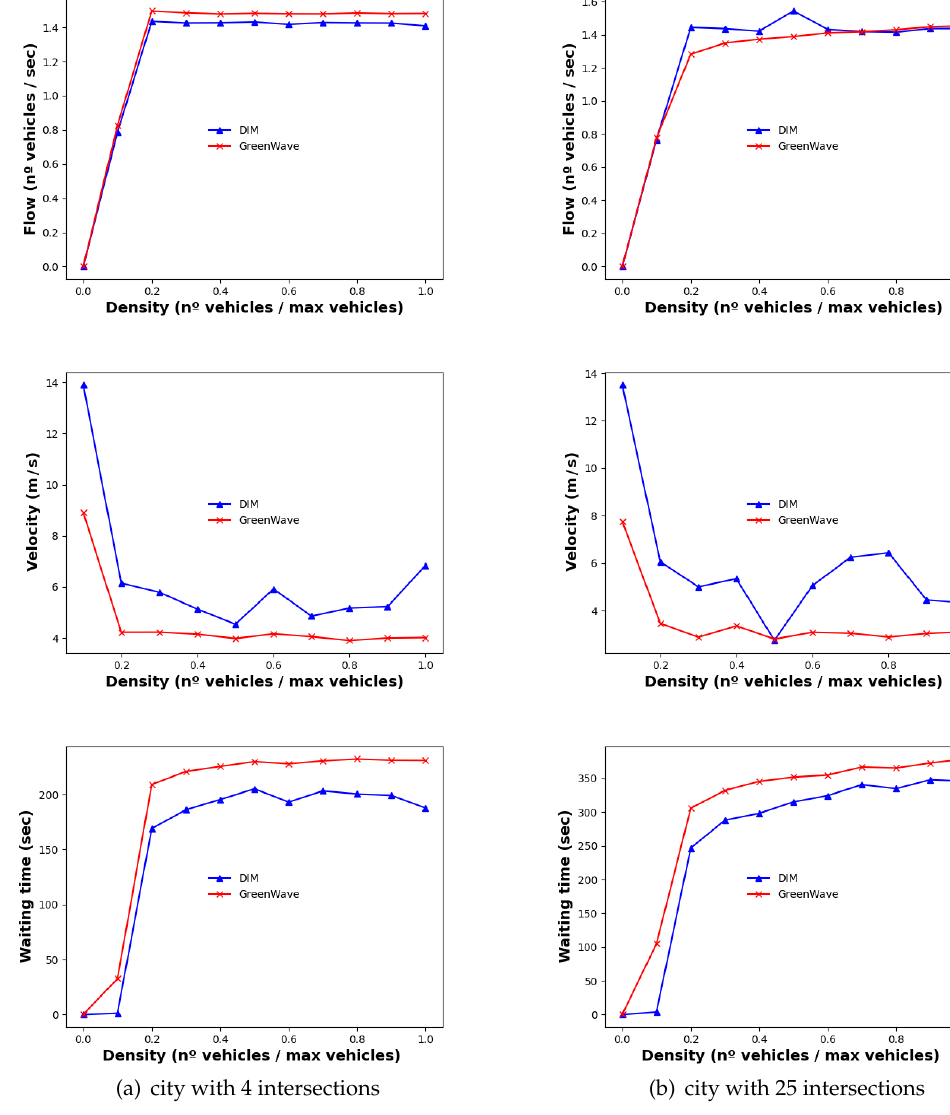
Figure 2. Models comparison without emergency vehicles on two different cities